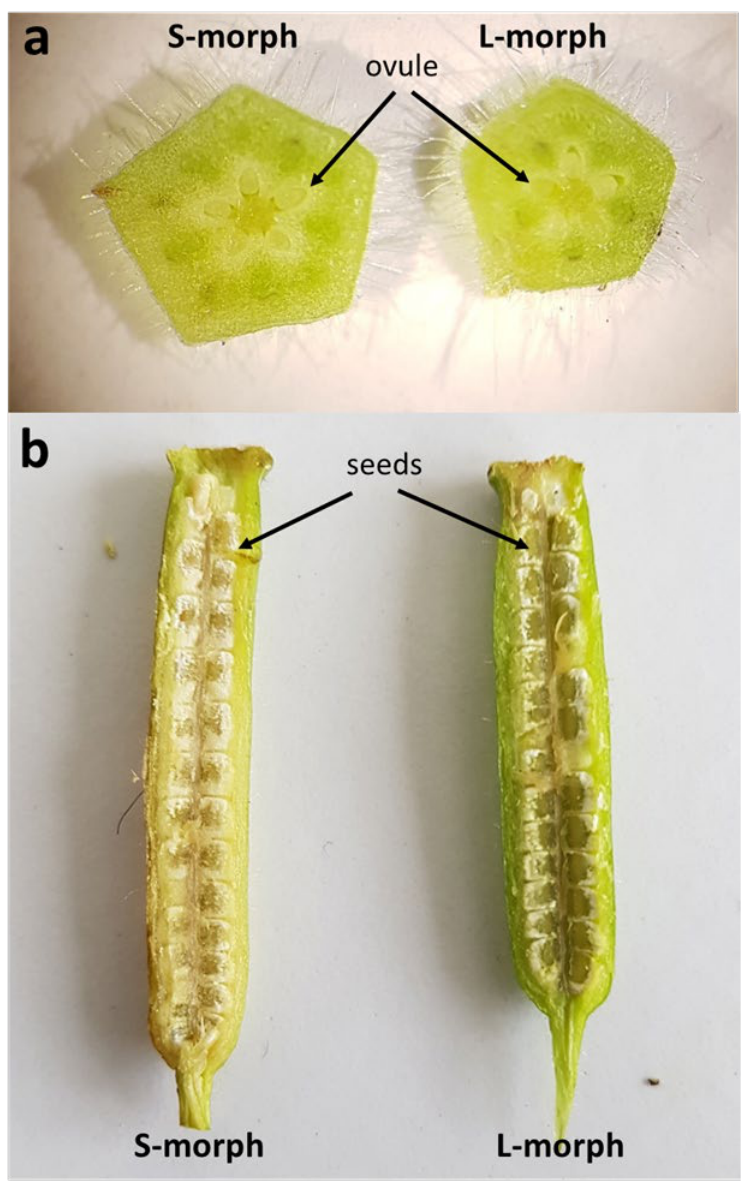
Figure S3: a) transversal and b) longitudinal sections of petaloculate ovary from 5-merous floral morphs of Ludwigia grandiflora subsp . hexapetala